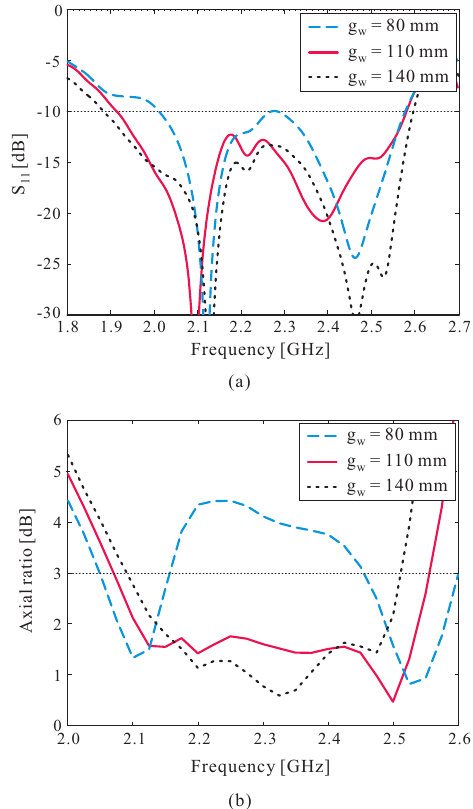
Figure 3. Simulated H-field distributions on the top surface of the proposed multiple-circular-sector dielectric resonator (DR) with time period T at: ( a ) 2.3 GHz; ( b ) 2.5 GHz.